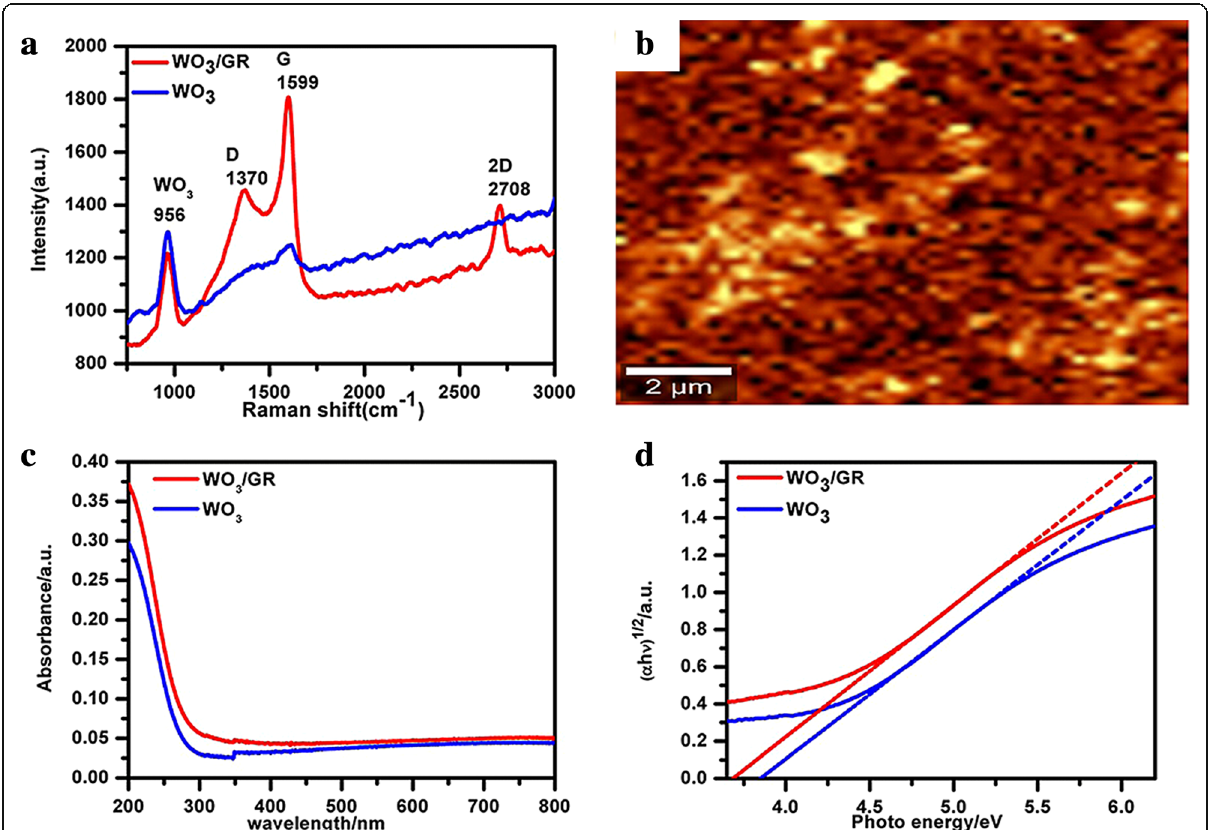
Fig. 2 a The Raman spectra of as-prepared samples. b Raman G-peak mapping image of as-prepared samples. c UV – vis absorption spectra of